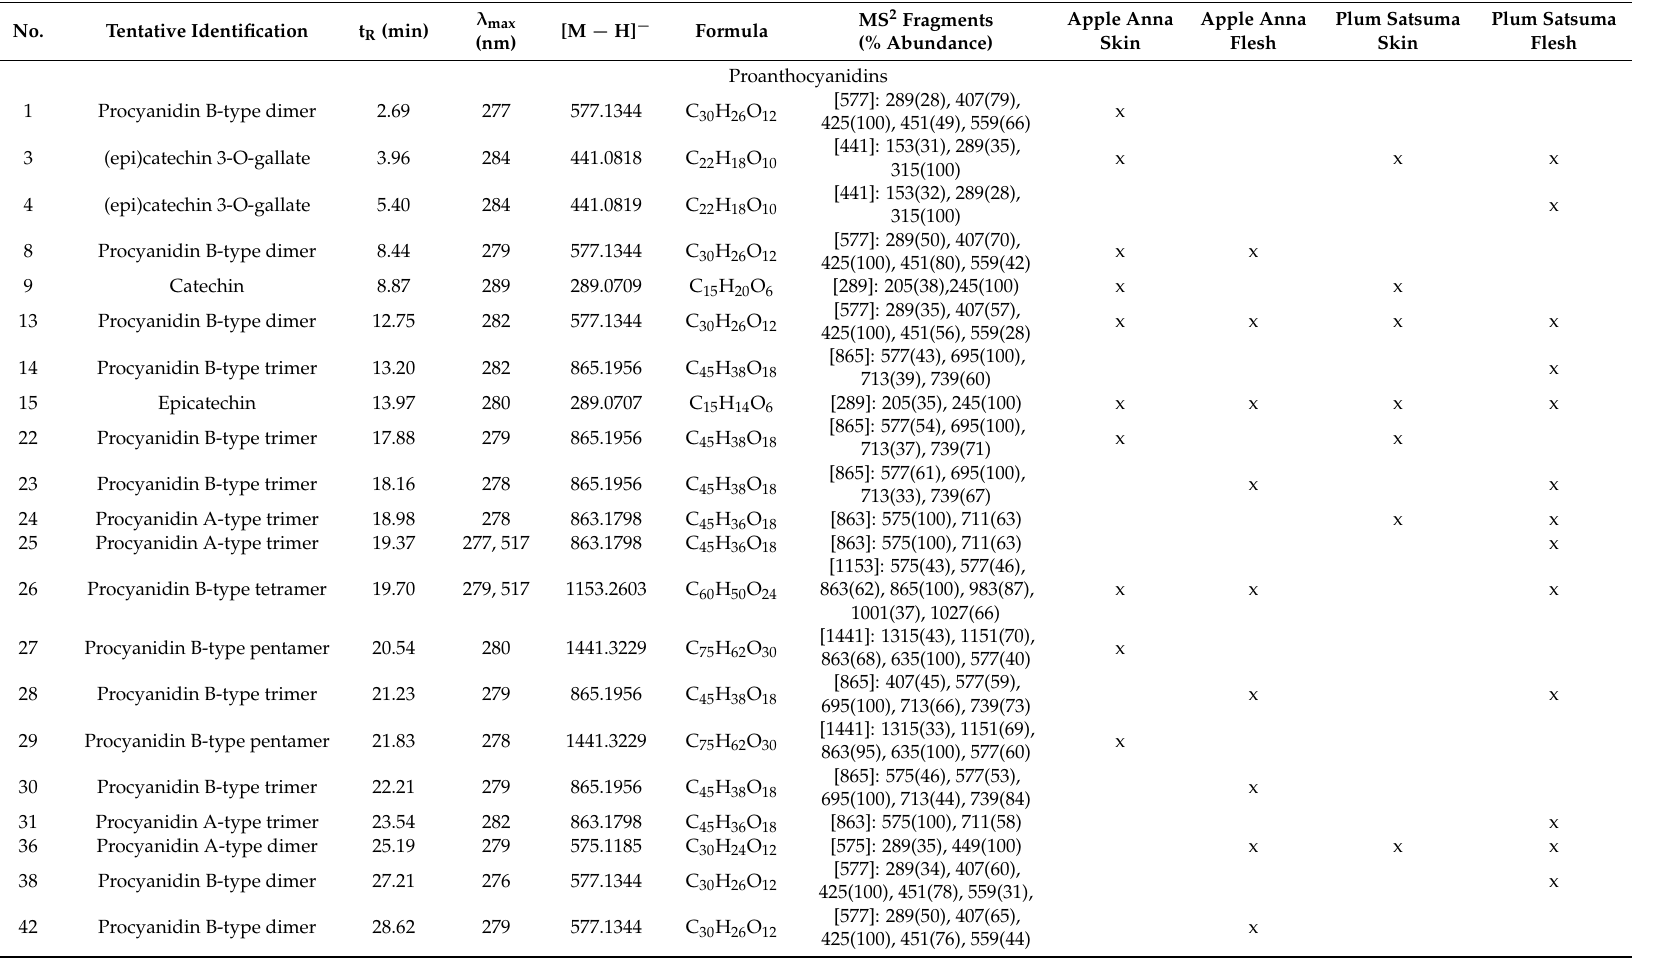
Table 2. Profile of phenolic compounds identified by UPLC-DAD-ESI-TQ-MS analysis for apple and plum